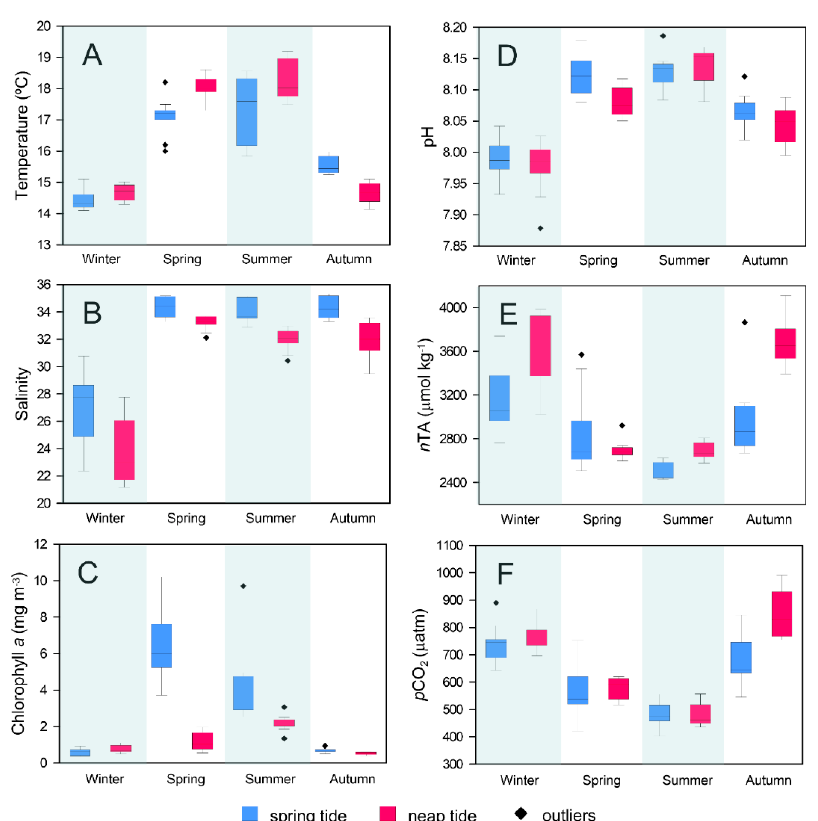
Figure 5. Box plots of ( A ) temperature, ( B ) salinity, ( C ) chlorophyll a , ( D ) pH, ( E ) normalized alkalinity ( n TA), and ( F ) CO 2 partial pressure ( p CO 2 ) for the sampling periods at the Tagus fixed station. Values are median with quartiles in boxes, 90% confidence limits are shown as bars, and observations outside 90% confidence limits are shown as diamonds (outliers).